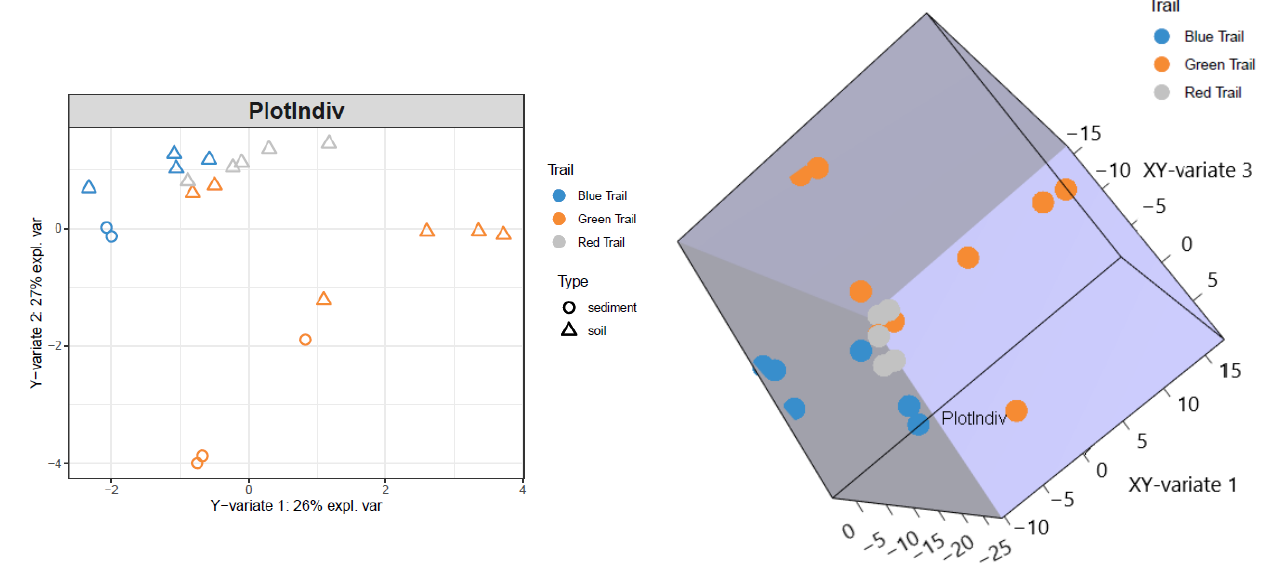
Figure 3. Sparse Partial Least Squares PCA plot of the samples in Y-variate space after optimization of the number of components using the root mean square error minimization. A 3D plot of the final sparse partial least squares PCA depicted in XY-variate space.